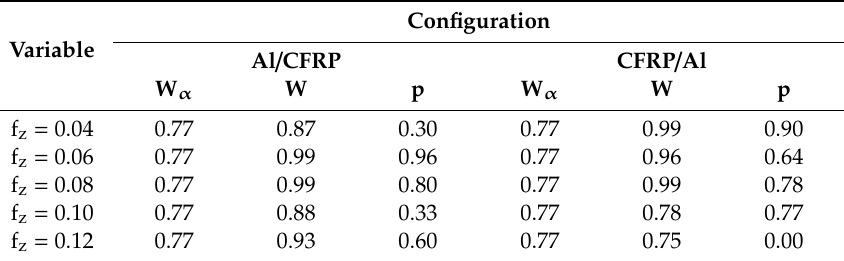
Table 8. Shapiro-Wilk test results for f z variable